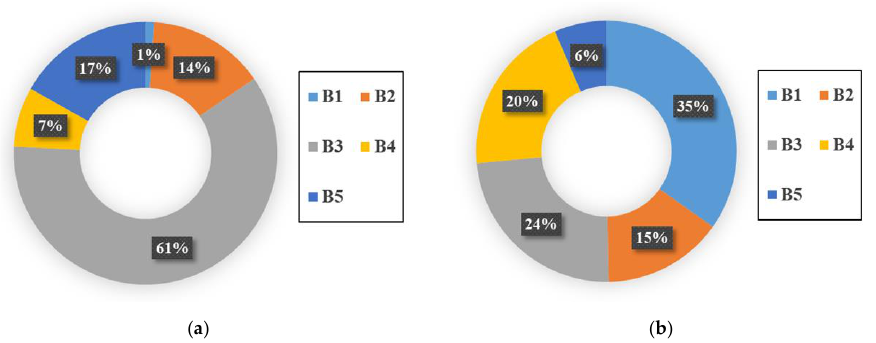
Figure 41. Comparison of the forecasts results of water production ratio per well: ( a ) Case 1; ( b ) Case 2.